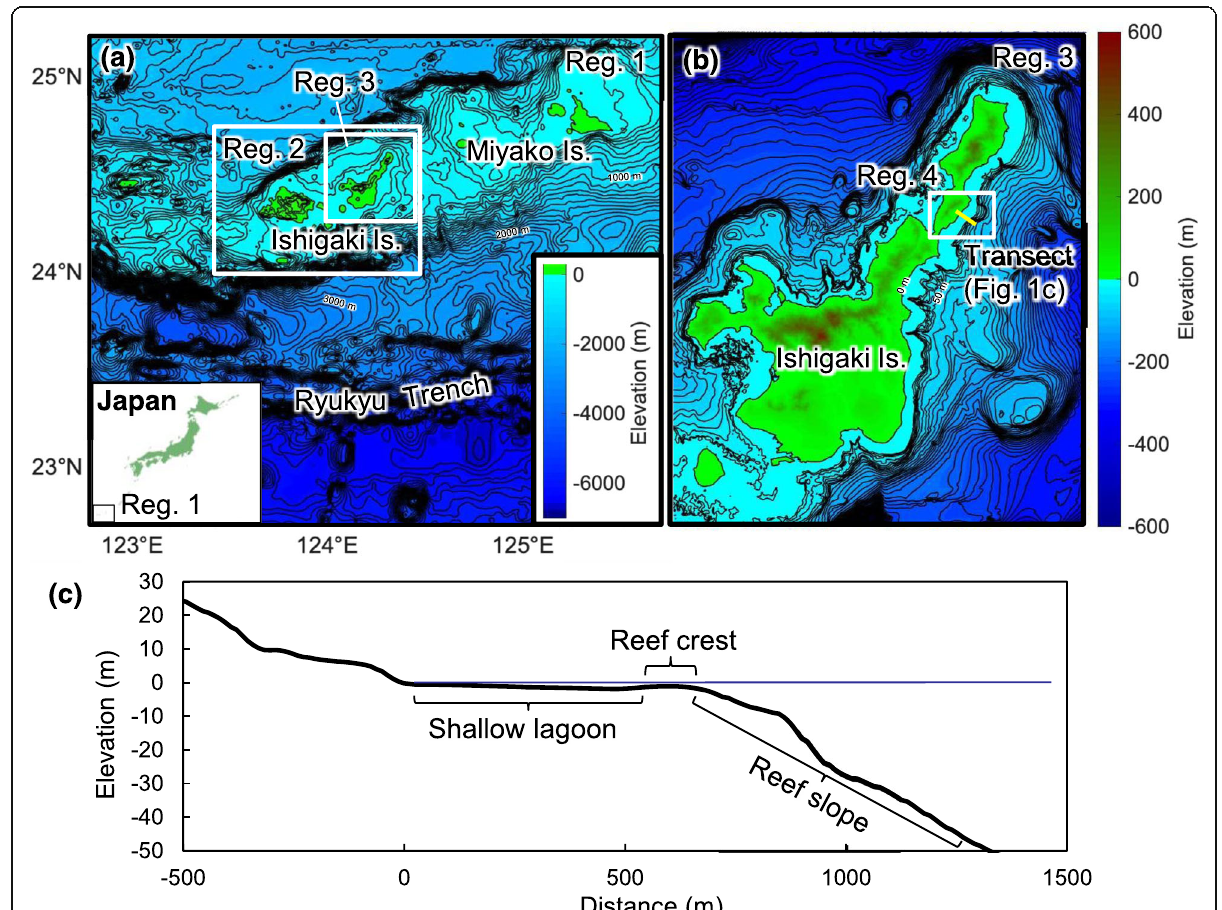
Fig. 1 a A map showing bathymetry and computational domains for this study from regions 1 to 4. A bathymetry contour line is 100-m interval. b A map showing Ishigaki Island and our survey area. A bathymetry contour line is 10-m interval. c A representative cross-sectional profile of elevation (m) at the Ibaruma reef reproduced from grid